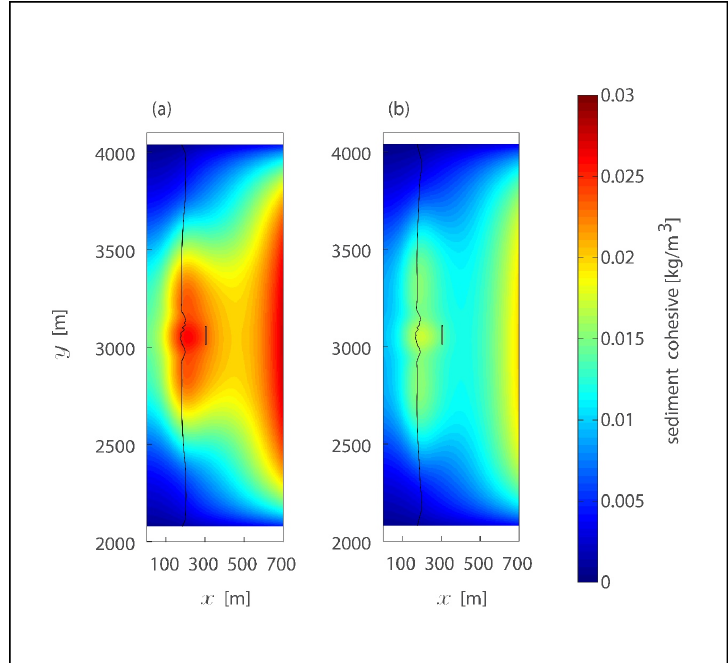
Figure 9. Sediment concentration Plot for the run with H s = 0.5 m, slope = 0.8%, Tide = ± 0.4 m and x d =100 m. ( a ) Sediment concentration = 0.4 kg/m 3 and ( b ) Sediment concentration = 0.2 kg/m 3 . An important aspect related to the sediment deposition into the salt marsh appeared, after comparing the volume accumulated behind the breakwater (into the marsh) and far away from it, revealing how breakwaters block sediment transport and prevent nourishment of the marsh (Figure 10).